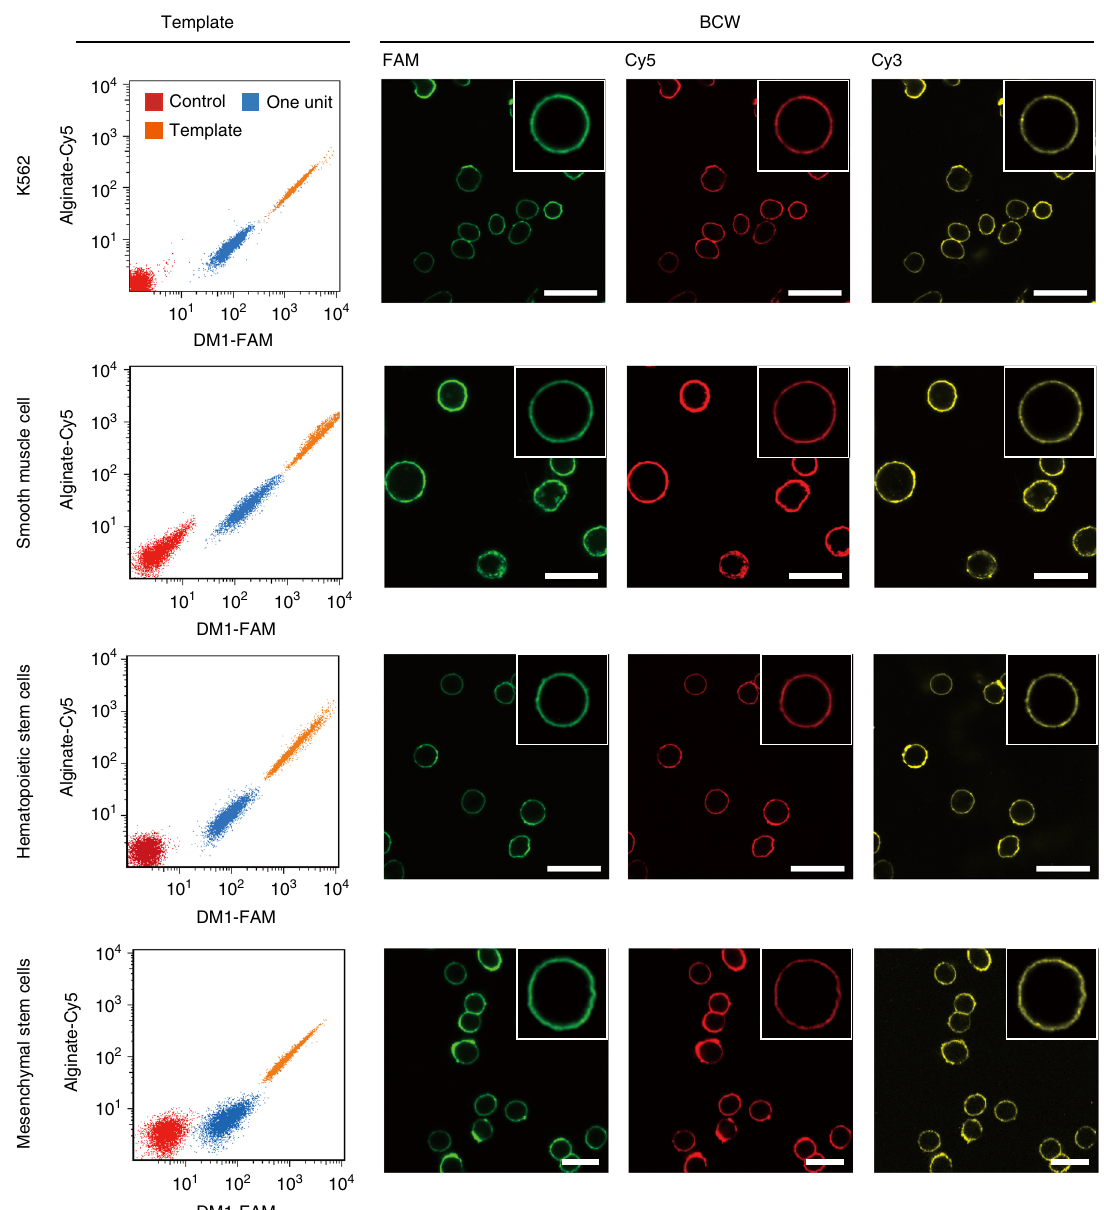
Fig. 4 Formation of BCW on different types of cells. a Flow cytometry analysis of the template. b Confocal fl uorescence images of BCW. Scale bar: 30 μ m. FAM: DM1-FAM; Cy5: alginate-Cy5; Cy3: